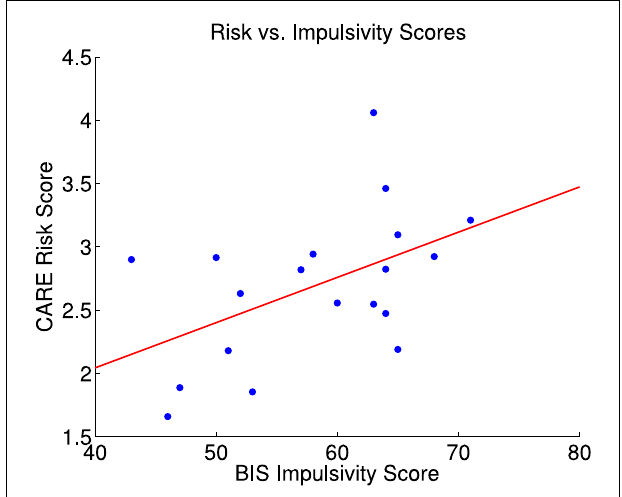
FIGURE 2 | CARE risk scores vs. BIS impulsivity scores for 19 participants. The red line is the best fit linear regression of CARE scores against BIS scores. Correlation between BIS and CARE scores was 0.50 (significant, p = 0 . 030 , t = 2 . 36 , df = 17 ). BIS scores explained 20.3% of the variance in the CARE scores. The largest statistical influence (Cook’s distance D) across all data point was 0.487.